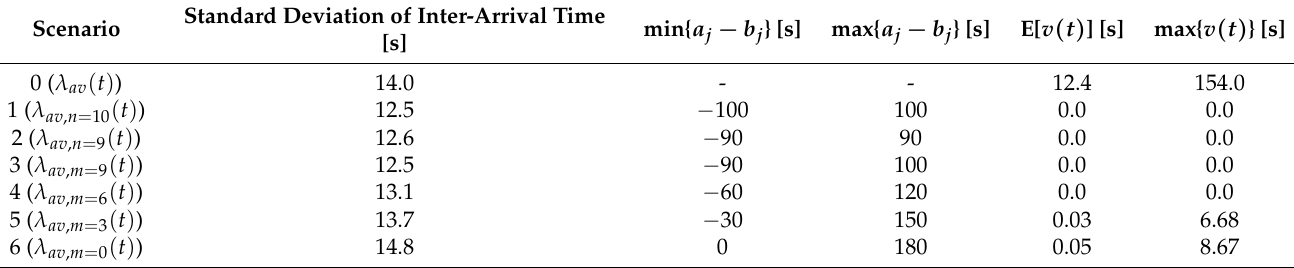
Table 4. Calculation results for Scenarios 2 to 6 with Scenario 0 and